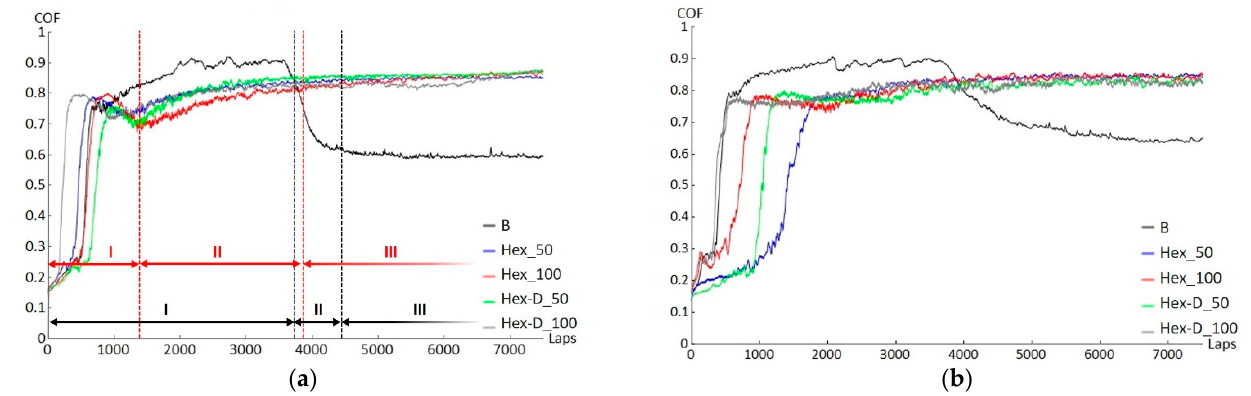
Figure 6. Coefficient of friction ( COF ) for unlubricated tests and exemplification of friction stages; ( a ) sliding radius 10 mm, normal load 5 N (R10_N5), ( b ) sliding radius 5 mm, normal load 2 N (R5_N2).